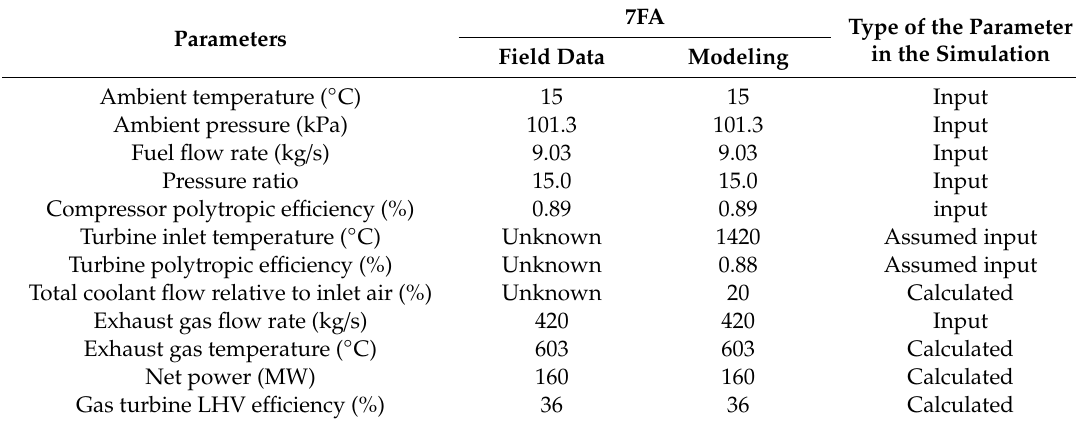
Table 1. Specifications of the target gas